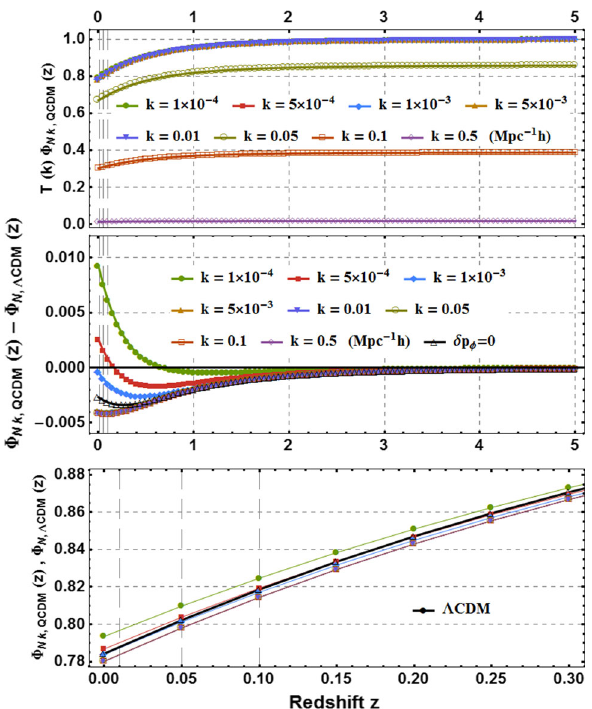
Fig. 3 Top: evolution of the weighted gravitational potential T ( k )(cid:5) Nk ( z ) at selected scales. Middle: residue of (cid:5) Nk ( z ) between QCDMand (cid:4) CDM,withtheadditionalcase δ p φ = 0inEq.(9)(black). Bottom: enlarged plot of (cid:5) Nk ( z ) in QCDM with the same scales as in top panel, compared with (cid:5) N ( z ) in (cid:4) CDM (black). The three vertical long-dashed lines correspond to z = 0 . 01, 0 . 05 and 0 . 1, respectively